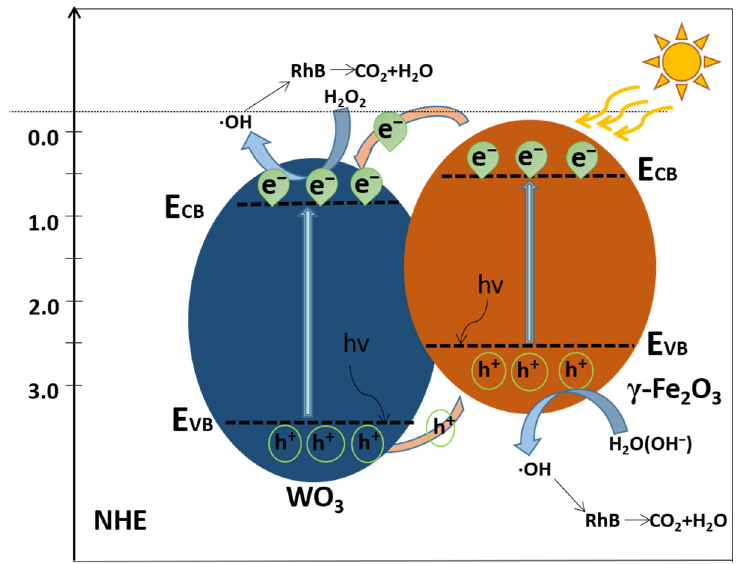
Figure 8. A possible mechanism for the charge-transfer mechanism in γ -Fe 2 O 3 /WO 3 ·0.5H 2 O.